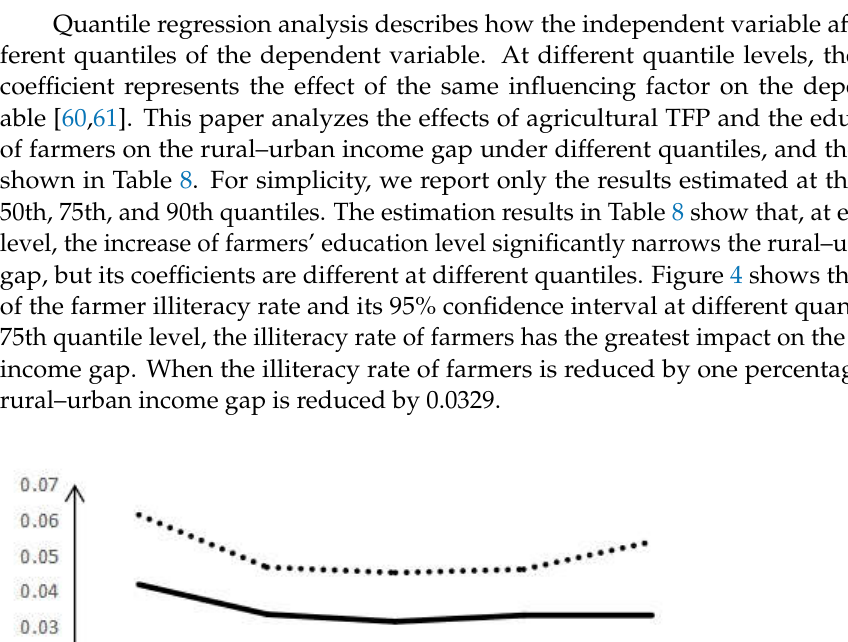
Table 8. Estimate results of quantile regression.